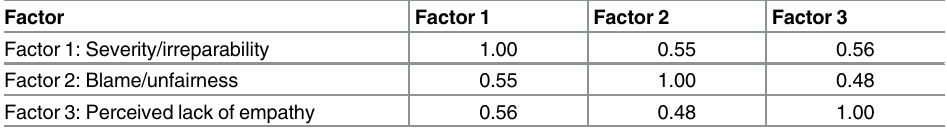
Table 3. Correlations between factors of IEQ-J.